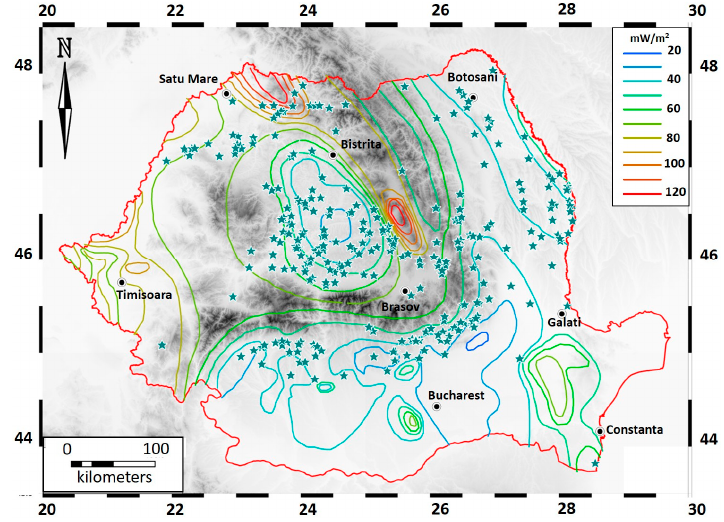
Figure 10. Distribution of seeps with unknown activity and uncertain seeps in relation to the heat flow (references as in Figure 9).